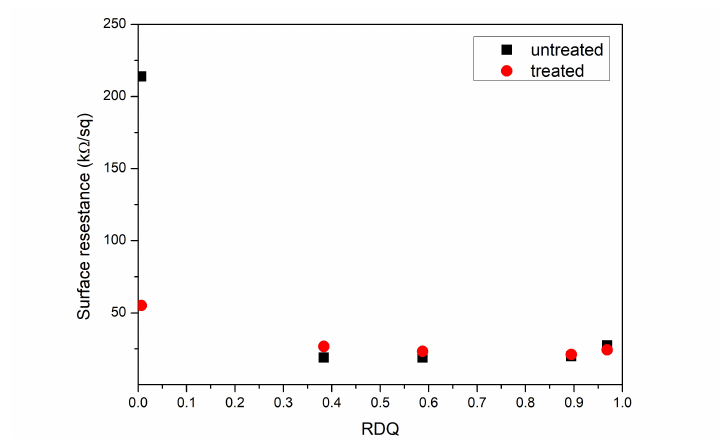
Figure 2. Surface resistance of untreated and post treated samples with different relative dispersion qualities.